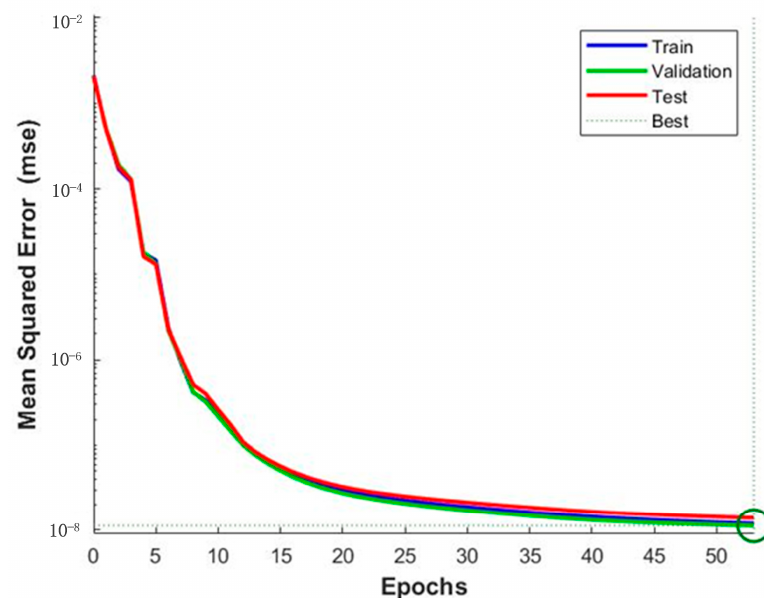
Figure 16. MSE of the network. Table 8. Network parameters.